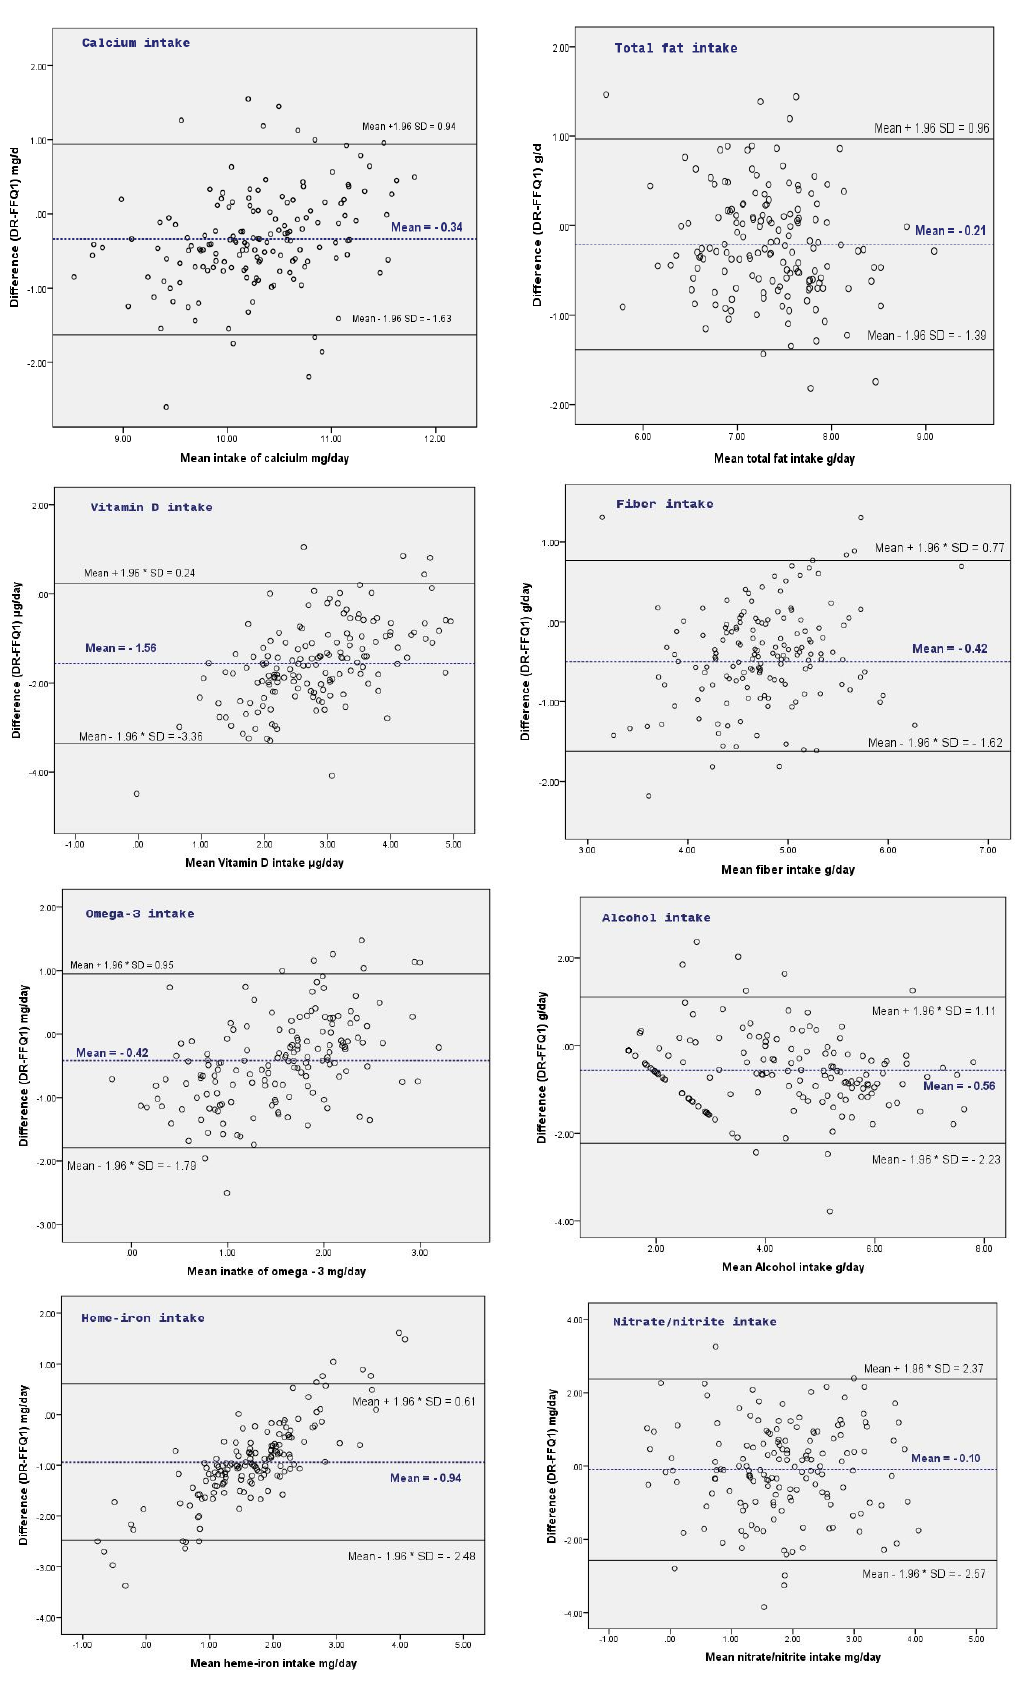
Figure 1. Bland and Altman plots for the log-transformed data of nutrients between the 3-days diary (DR) and FFQ1 ( n = 156).